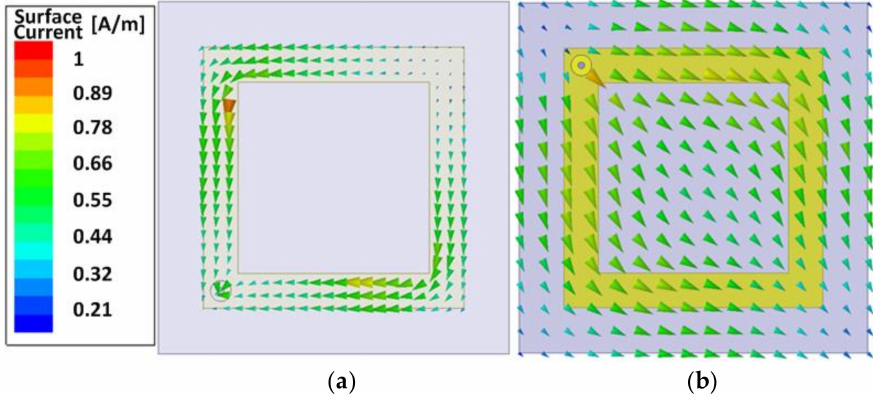
Figure 5. Surface current distribution on the ( a ) square ring and ( b ) back ground of the MS structure at the resonant frequency (2.5